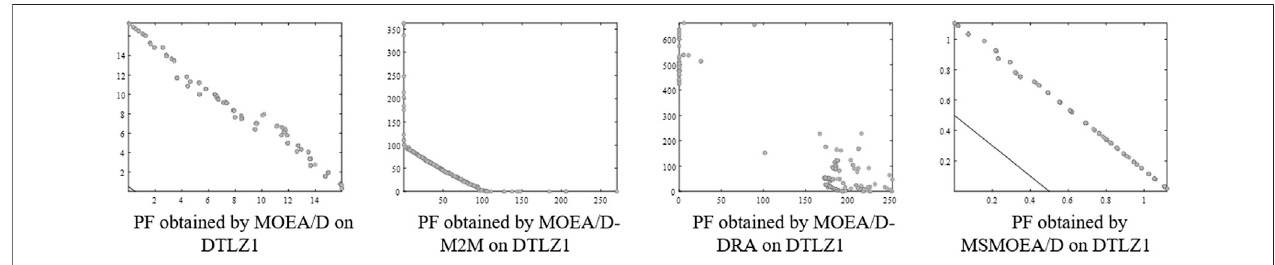
FIGURE 4 | PF obtained by MSMOEA/D and MOEAs on two-objective DTLZ1.